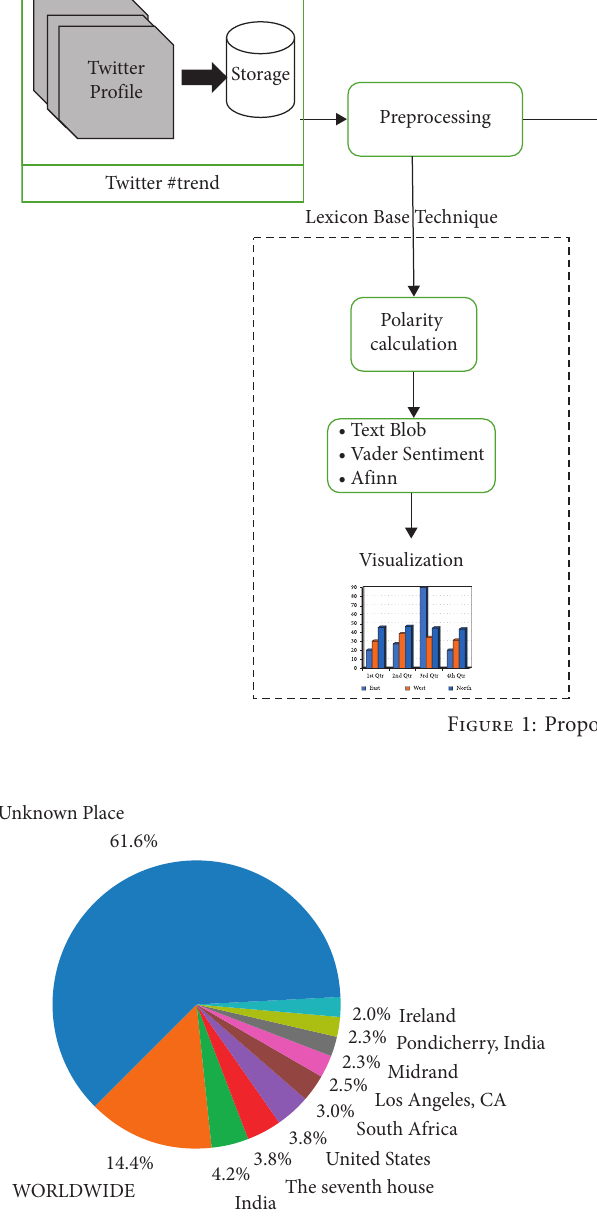
Figure 2: Percentage of tweets according to their